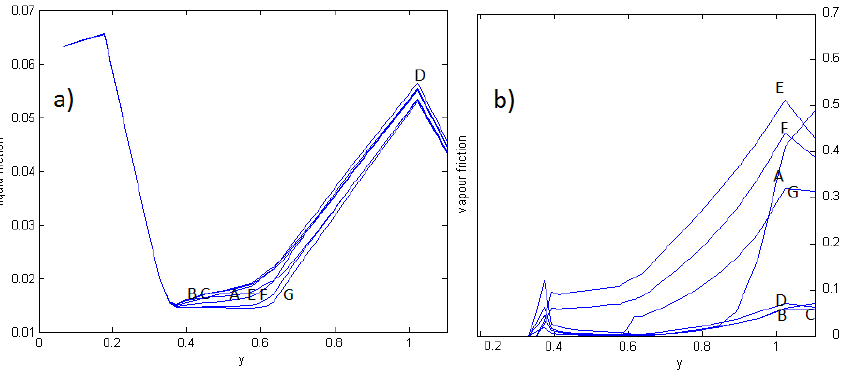
Figure 5. Wall friction: ( a ) liquid; ( b )